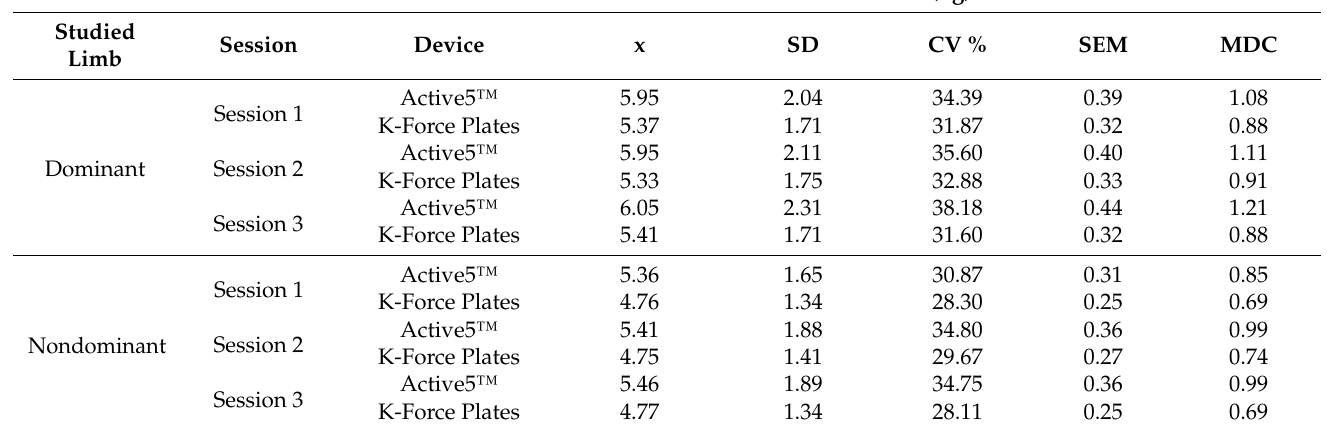
Table 15. The results of force measurements at 135 ◦ of shoulder abduction using Active5™ and K-Force